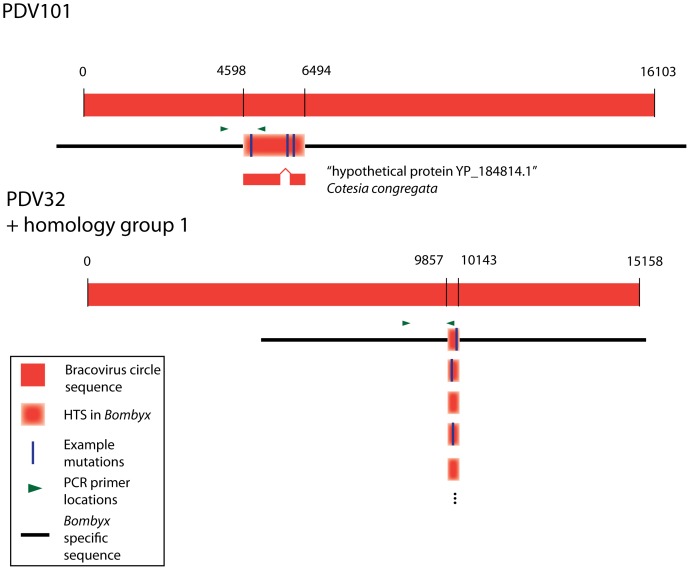
Two examples of HTS found in Bombyx (the same two HTS targeted for PCR in
Figure 4
) aligned to bracovirus sequences from Cotesia congregata.The top portion shows a HTS (PDV101) aligned to Cotesia congregata bracovirus circle 12 (NC_006644.1). Predicted protein in the donor sequence shown (YP_184814.1). The bottom portion show a HTS (PDV32) aligned to Cotesia congregata bracovirus circle 5 (NC_006637.1). PDV32 is part of homology group 1, which is shown aligned to PDV32. In both examples the HTS have undergone point mutations and insertion/deletions that are too numerous to accurately represent here so example mutations have been drawn. Primers used in the PCR reaction shown in Figure 4 are shown with green triangles.